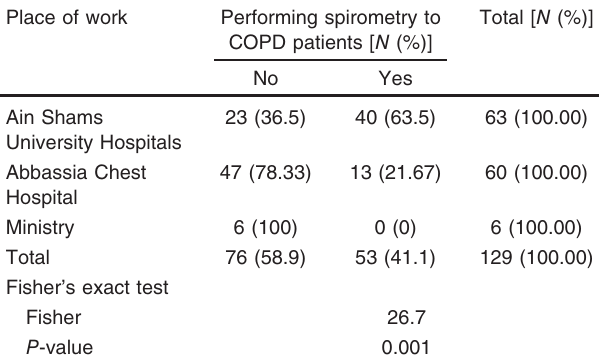
Table 12 Comparison between doctors ’ place of work and performing spirometry to chronic obstructive pulmonary disease patients Place of work